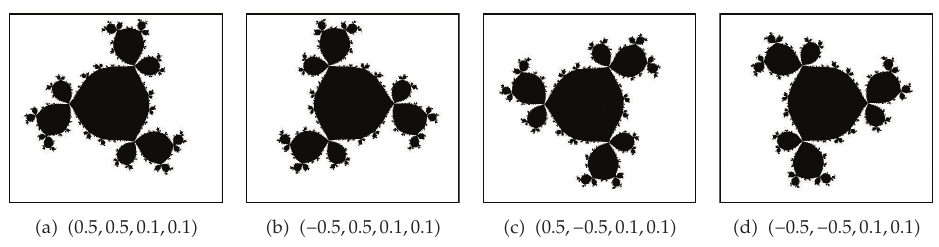
Figure 12: The generalized J sets perturbed by multiplicative noise when α (cid:6) 3.